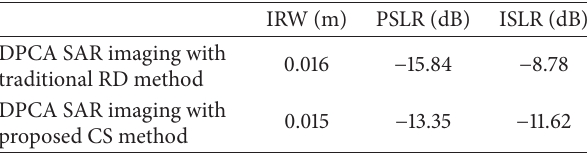
Figure 12: Azimuth effective phase centers of ground-based SAR system. Table 3: Comparison of performance for imaging results.